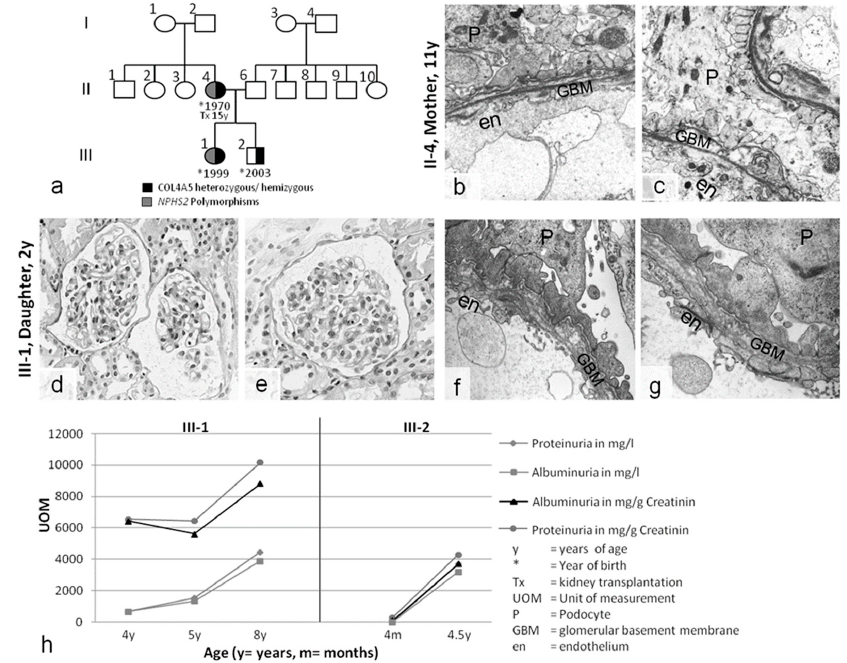
Figure 2. ( a ) Pedigree of case 2. ( b , c ) Kidney biopsy of the mother (11 y) revealing partial